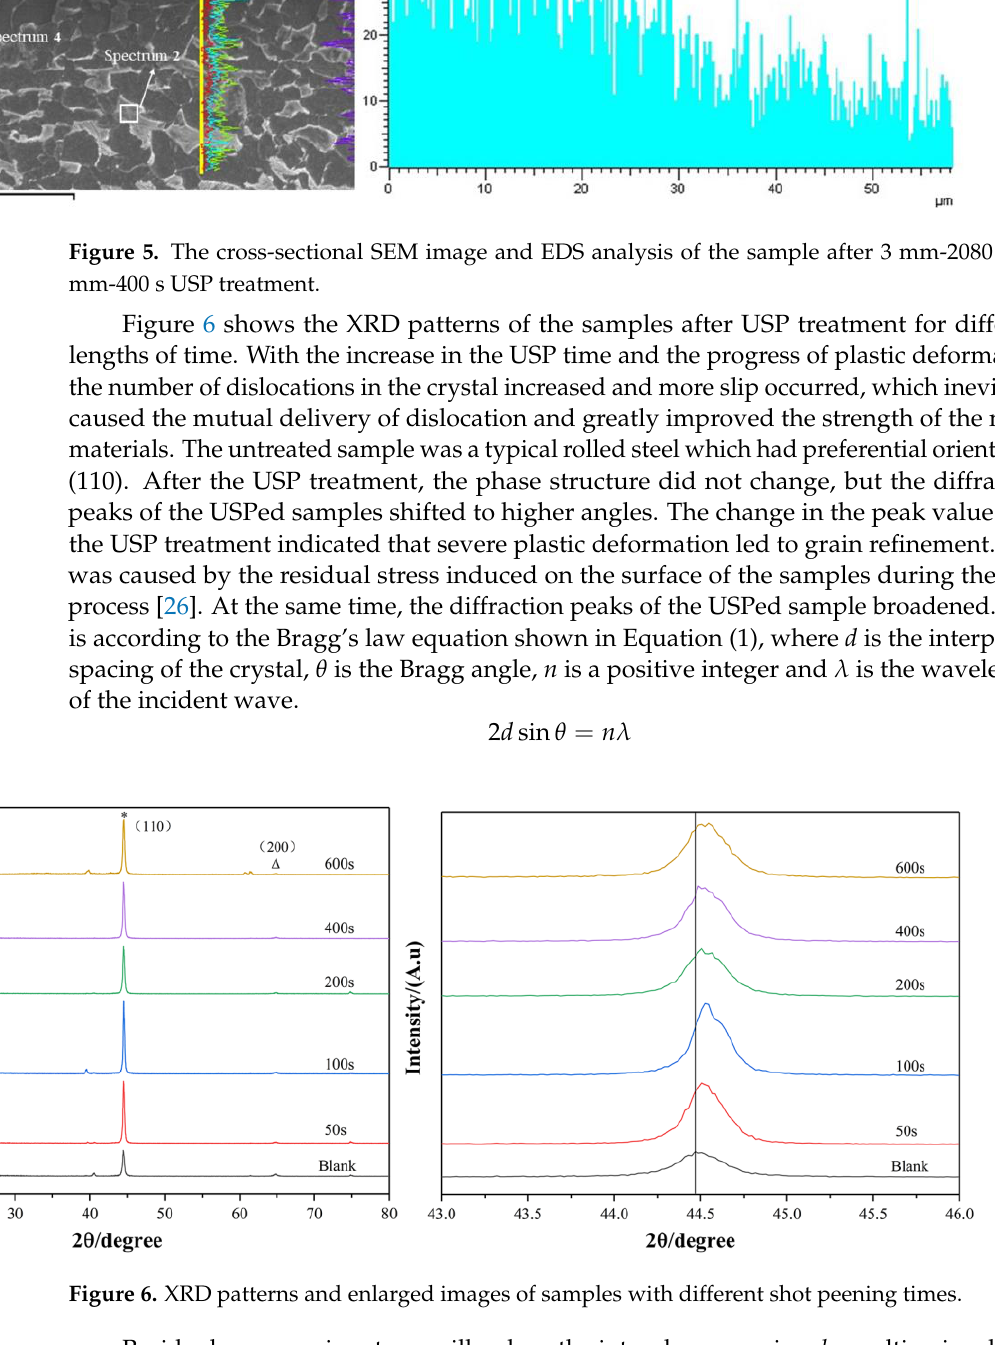
Figure 5. The cross-sectional SEM image and EDS analysis of the sample after 3 mm-2080 W-11 mm- 400 s USP treatment.